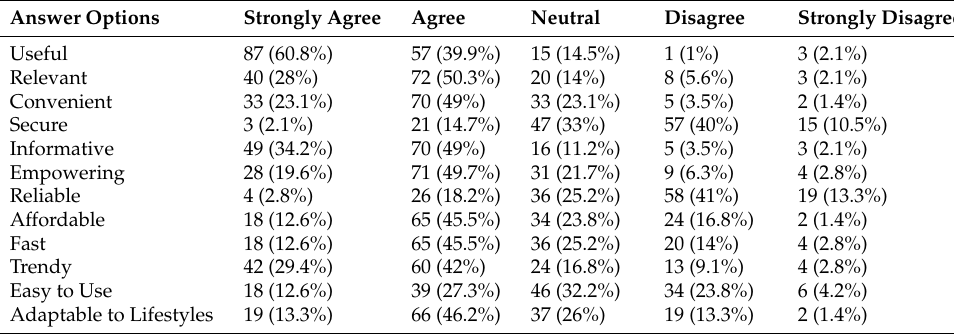
Table 2. Internet perceptions among